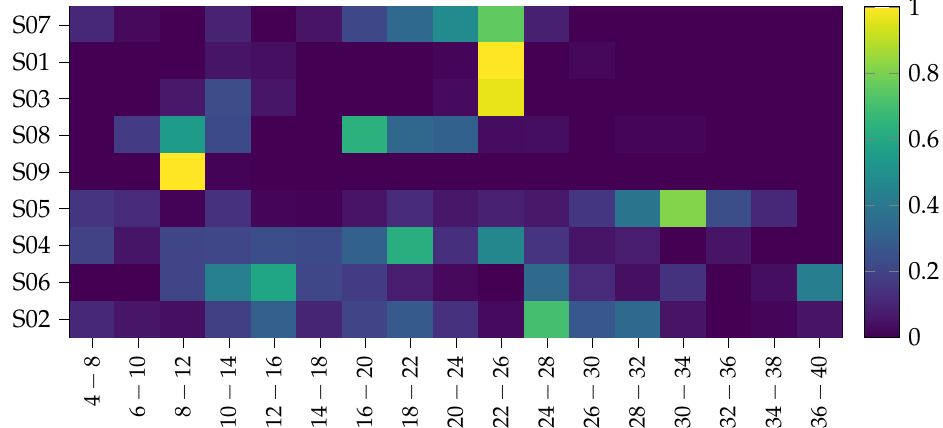
Figure 7. Projections of subject S05 trials using four spatial patterns approaches. Either PCA or KPCA maps to a 2D space features from (FB) CSP or MKSSP, respectively. ( a ) CSP. ( b ) FBCSP. ( c ) MKSSP ( W = I C ). ( d ) MKSSP ( Q ∗ = 4).